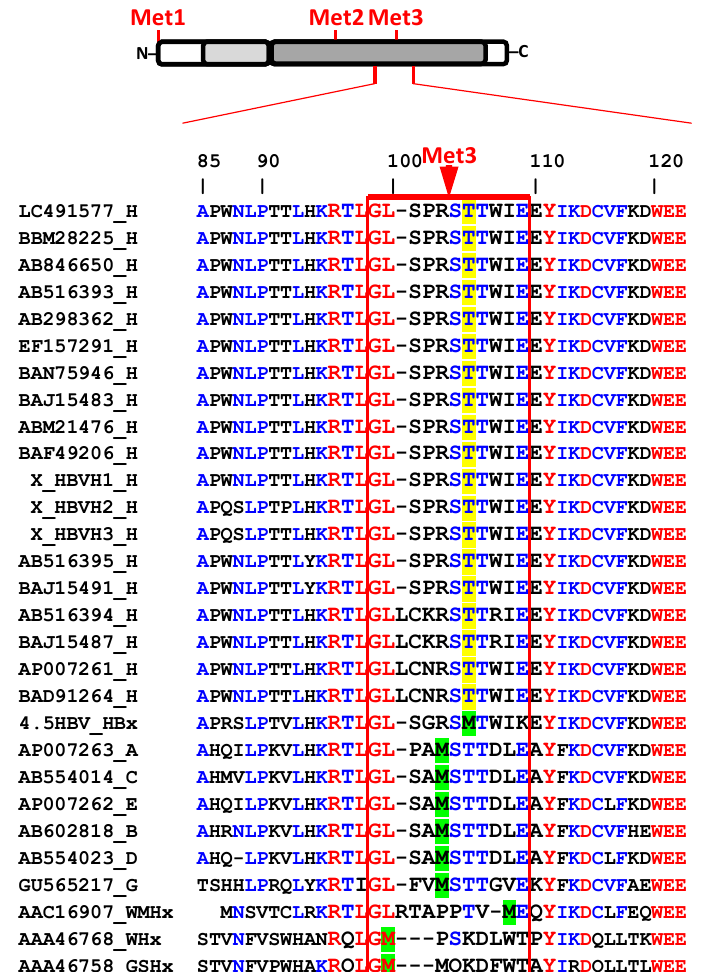
Figure 5. HBx XS small isoform is not expressed in HBV genotype H isolates. Multiple alignment of primary sequences of HBx proteins from all main human HBV genotypes, and chronic hepatitis B-type viruses from other organisms, such as woolly monkey hepatitis virus X protein (HMHx), woodchuck hepatitis virus X protein (WHx), and ground squirrel hepatitis virus X protein (GSHx) using multiple sequence comparison by log-expectation, the MUSCLE web server [132,133]. The alignment is magnified surrounding the Met3 position, between residues 85 to 122 of canonical HBx protein as indicated on top of the figure. HBx protein individual accession numbers are indicated in the left column, followed by the corresponding HBV genotype of each isolate or organism. The isolate 4.5HBV_HBx corresponds to our lab working HBV HBx genotype F1b isolate (GenBank: AIL83994.1) [27,28]. Individual residues across samples are colored as conserved (red), semi-conserved (blue) or non-conserved (black). Highlighted positions in bold and green indicate position of HBx Met3 in most of genotypes. Instead, highlighted position in bold and yellow indicate the corresponding conserved position of HBx Thr3, in HBV genotype H isolates, implicating the absence of Met3 in these